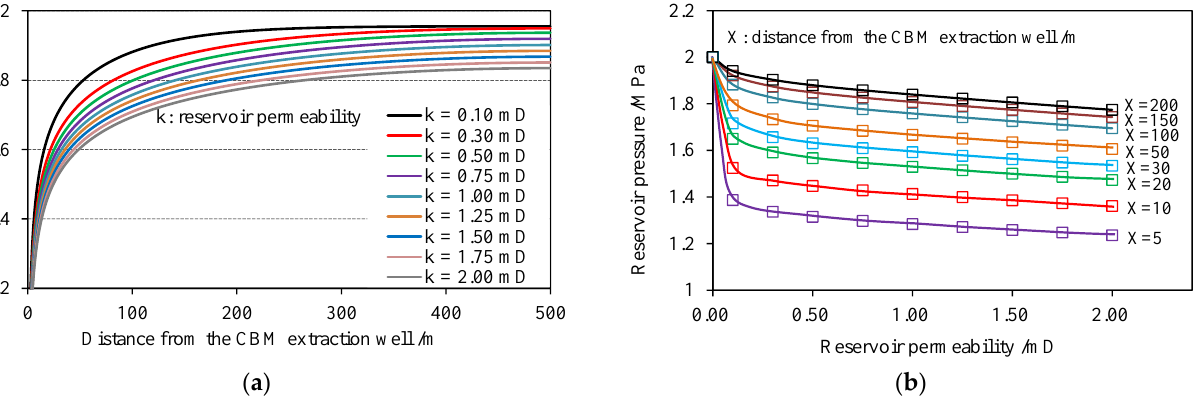
Figure 9. Reservoir pressure evolution varies with permeability after 5 years of CBM extraction. ( a ) reservoir pressure distribution at different distances from CBM well, ( b ) reservoir pressure at different permeability.